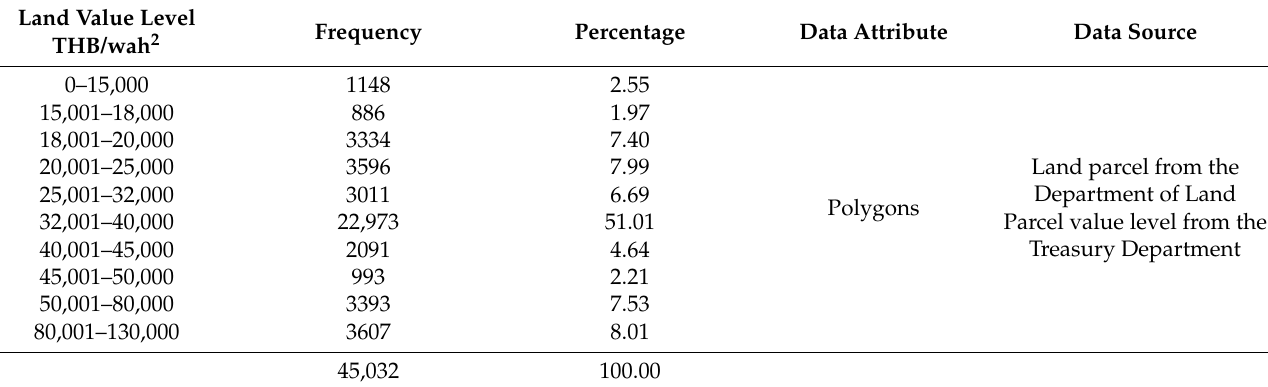
Table 2. Dependent variable or land value.